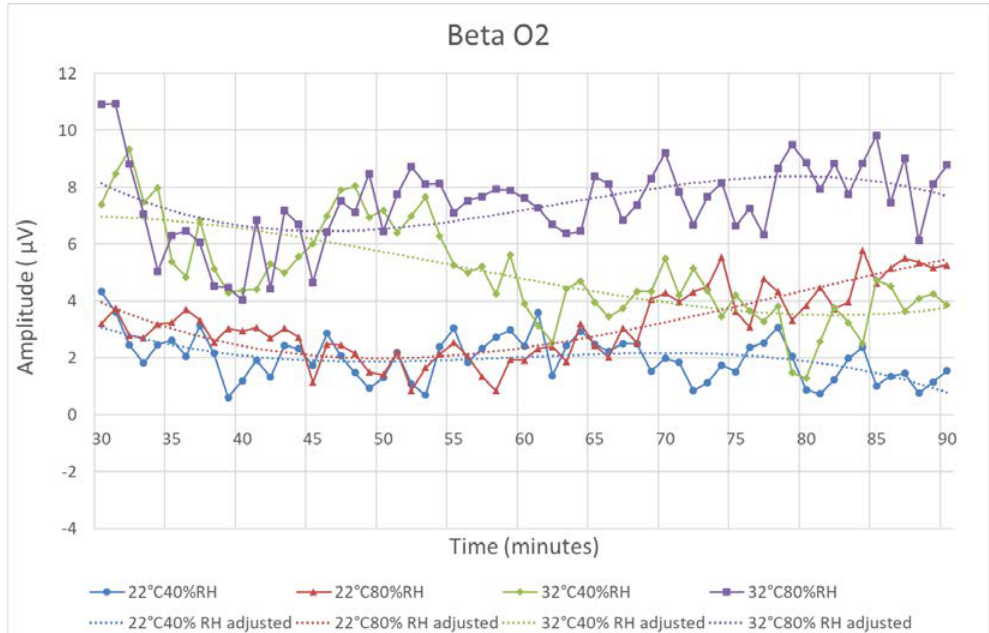
Figure 8. Mean values of Beta O2 waves from the 15 volunteers at different